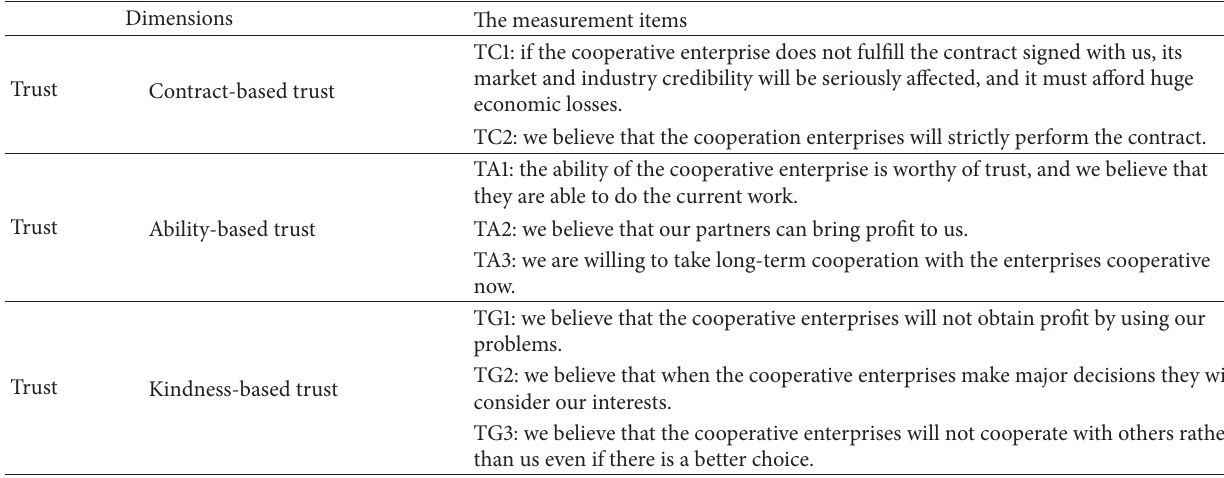
Table 3: The specific indexes of